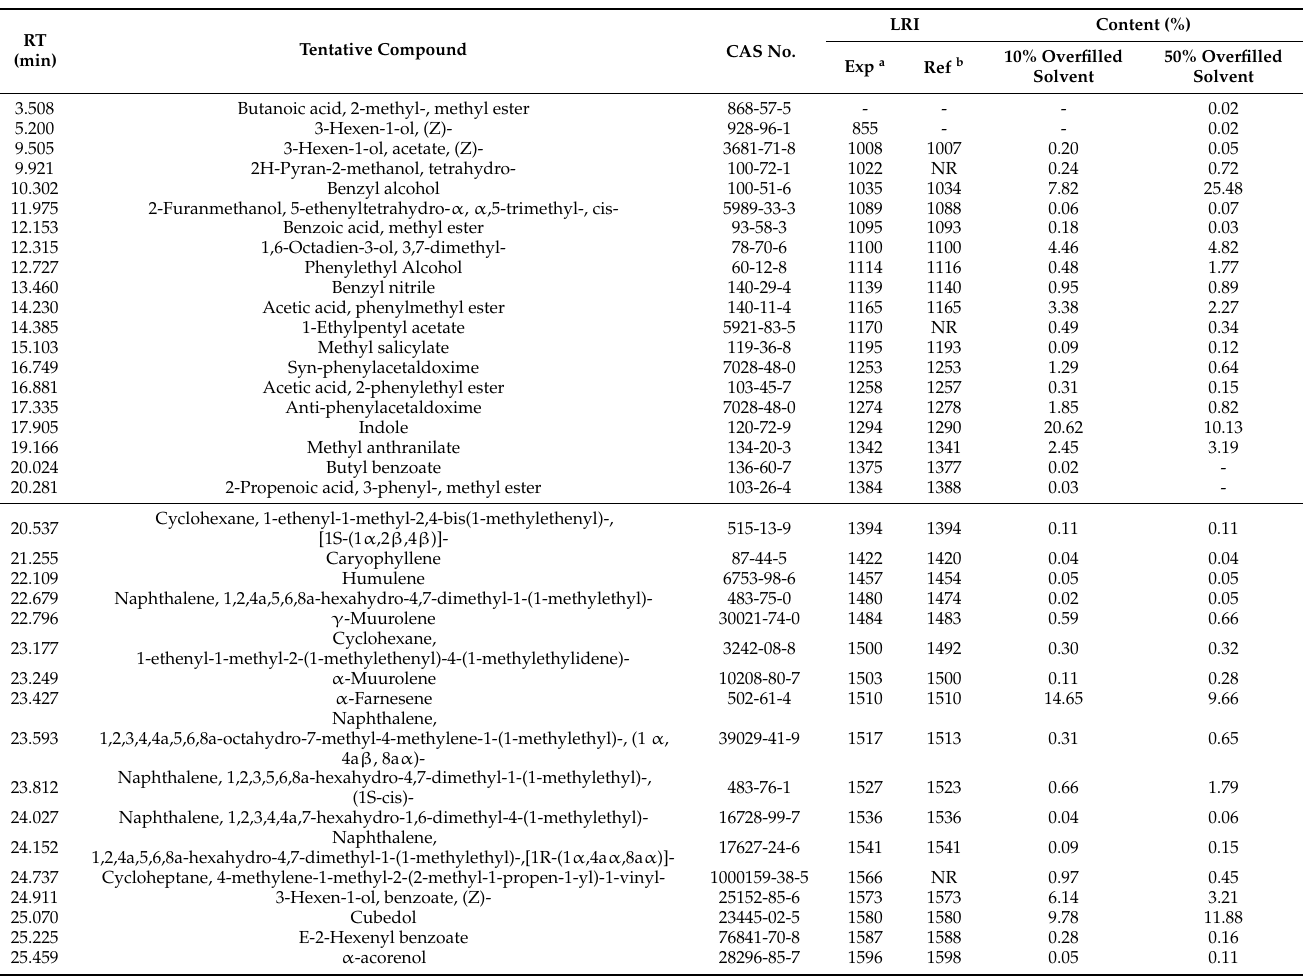
Table 2. Tentative volatile compounds of jasmine essential oil at 10% overfilled solvent and 50% overfilled solvent.